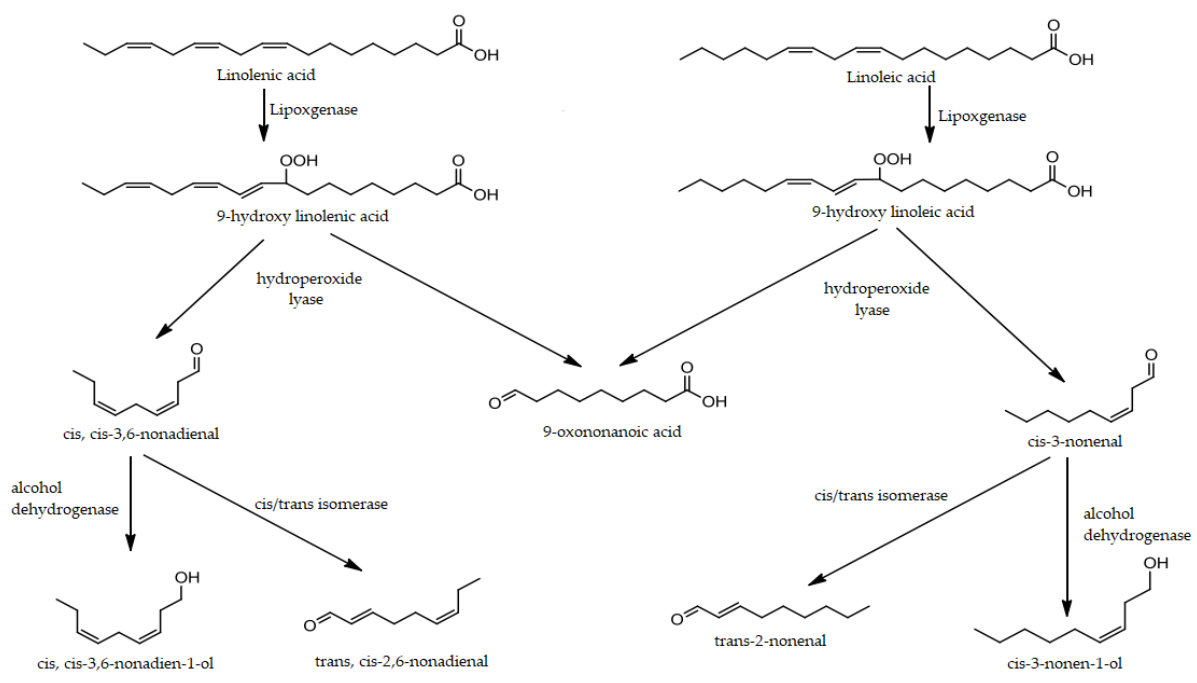
Figure 5. Proposed biosynthetic pathway for watermelon volatiles and their counterparts.